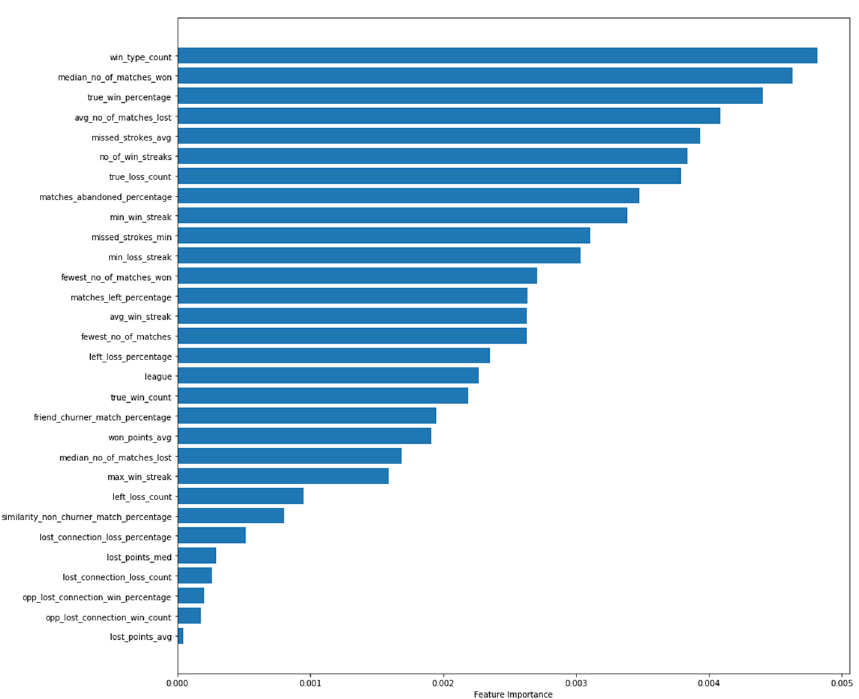
Fig. 6 Feature importance in the random forest model using the 5-day dataset and all the